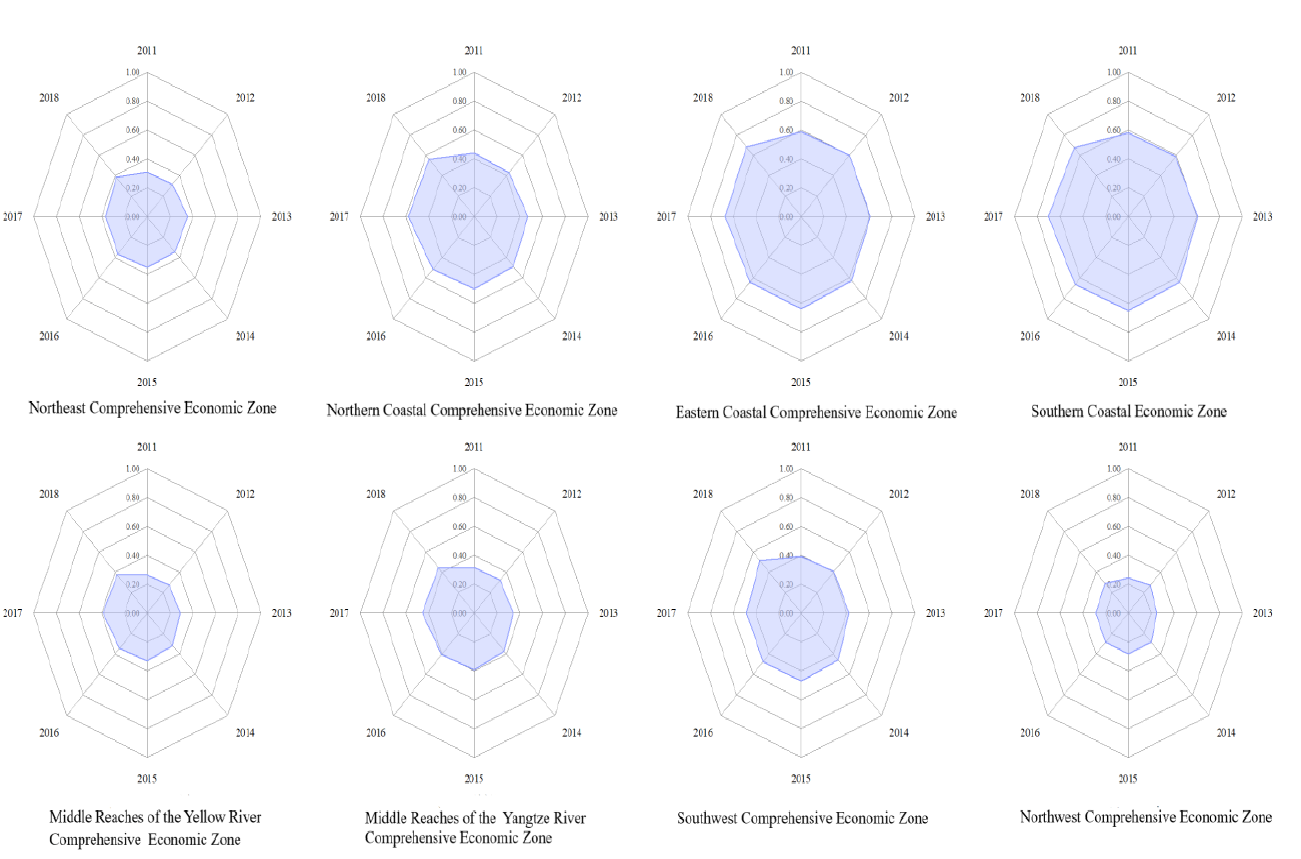
Table 4 calculated by the authors.